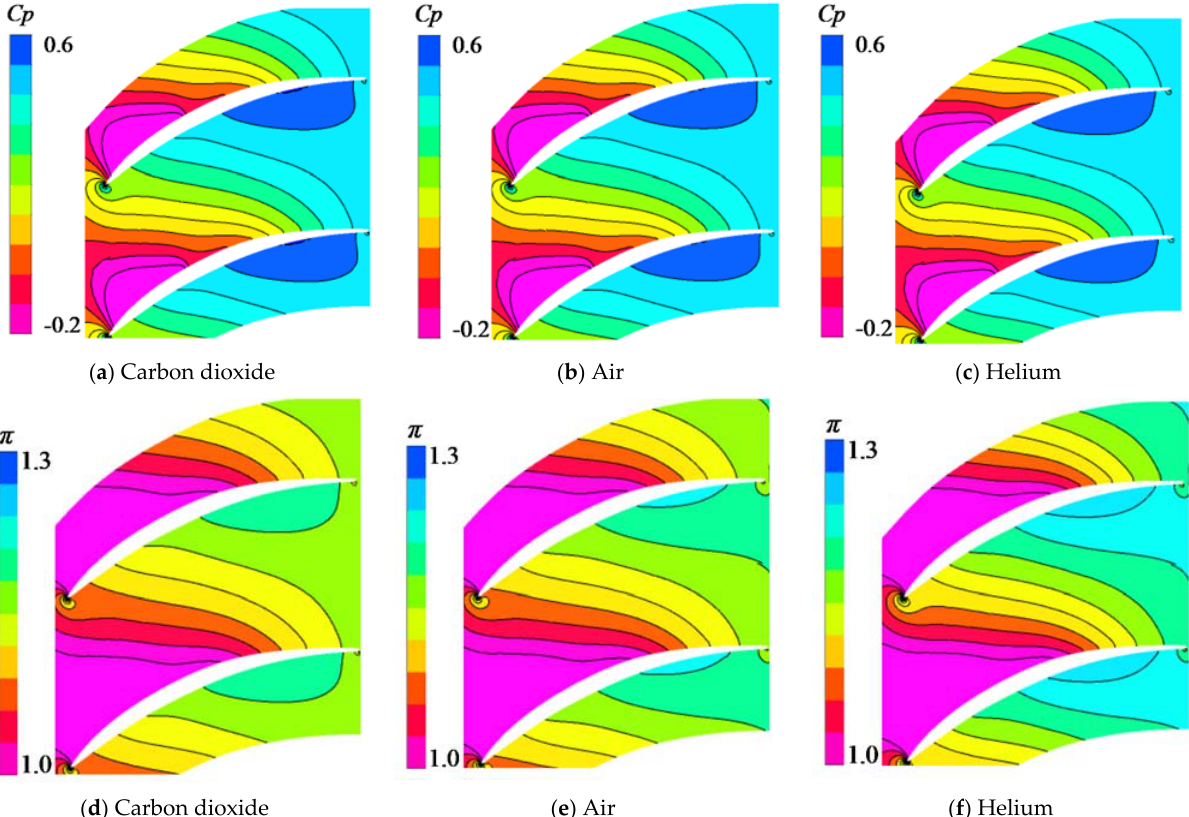
Figure 11. Static pressure coefficient (Cp) and static pressure ratio ( π ) distribution at 98% span for dissimilar working fluids (i = 0, Ma = 0.7).